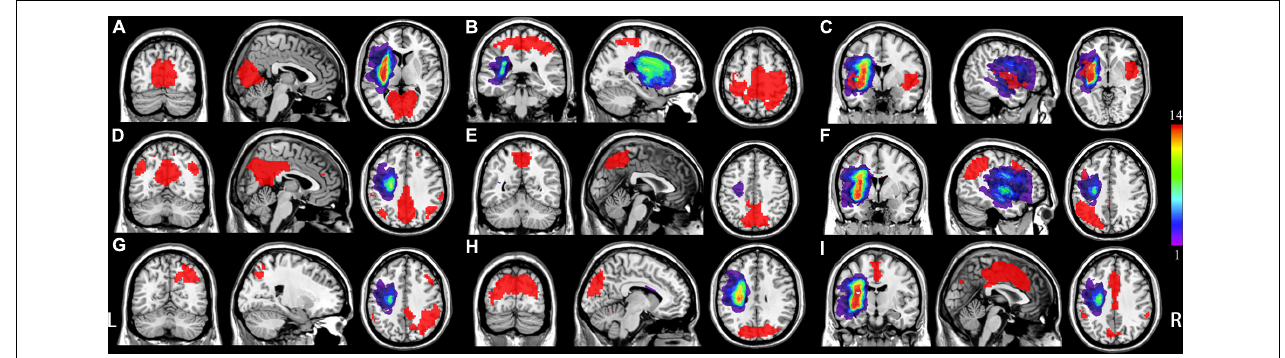
FIGURE 1 | Distribution of each individual lesion for all patients with post-stroke aphasia (PSA). Colors represent the number of patients. L represents left, and R represents right. (A) Medial visual network (mVN), (B) sensorimotor network (SMN); (C) salience-related network (anterior insular cortex); (D) posterior default mode network (pDMN); (E) visual-spatial network (VisN); (F) left frontoparietal network (lFPN); (G) right frontoparietal network (rFPN); (H) lateral visual network (lVN); (I) salience-related network (anterior cingulate cortex).